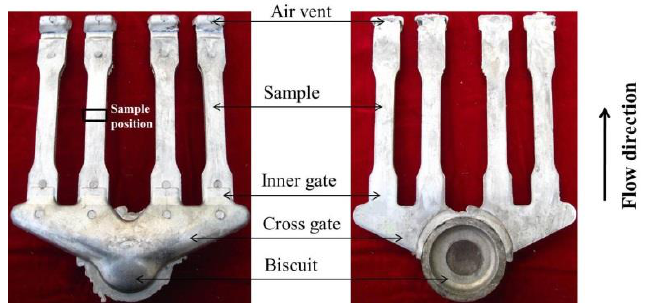
Figure 1. Photograph of the RDC product.